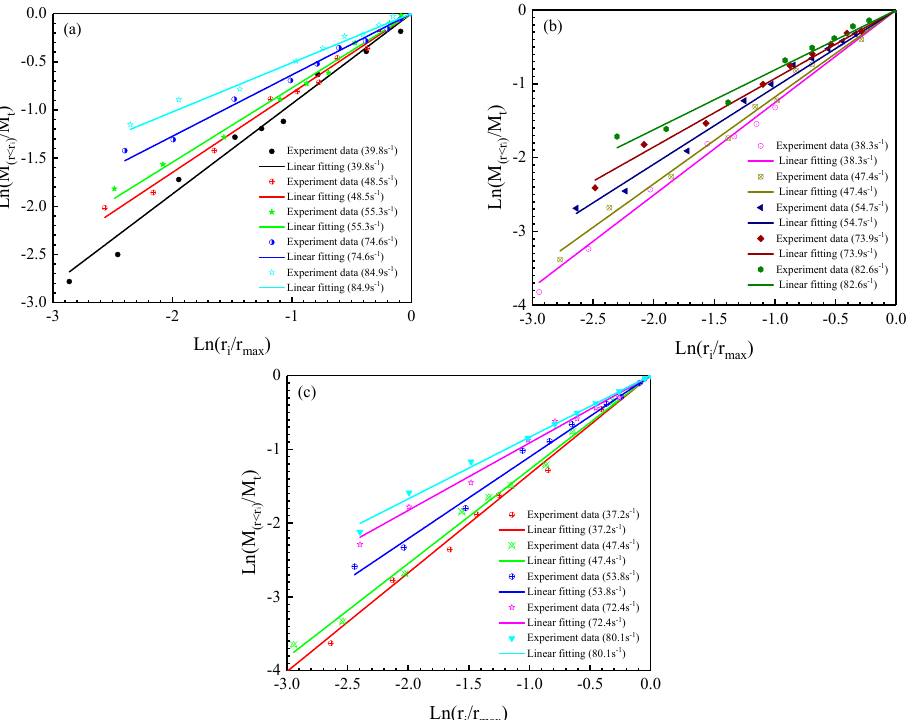
Figure 13. Fractal characteristics of S 5 series samples fragments under different strain rates: ( a ) T = 0.5; ( b ) T = 1.0; ( c ) T = 2.0. Table 3. Fractal fitting of cemented rock samples with different strain rates. Sample No.